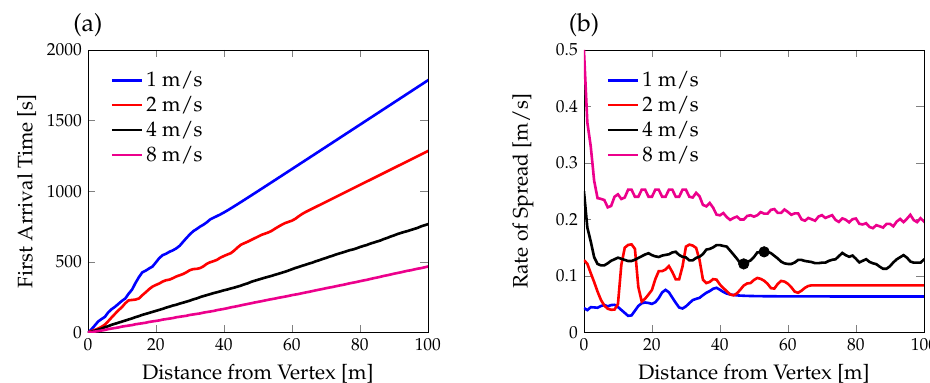
Figure 4. ( a ): The first arrival time along the vertical line passing through the middle of the head. Heat maps of three of the first arrival times are shown in Figure 3. ( b ) The rate of spread, defined using Equation (7), of the vertical line passing through the middle of the head. The configurations at the two black marks are illustrated in Figures 5 and